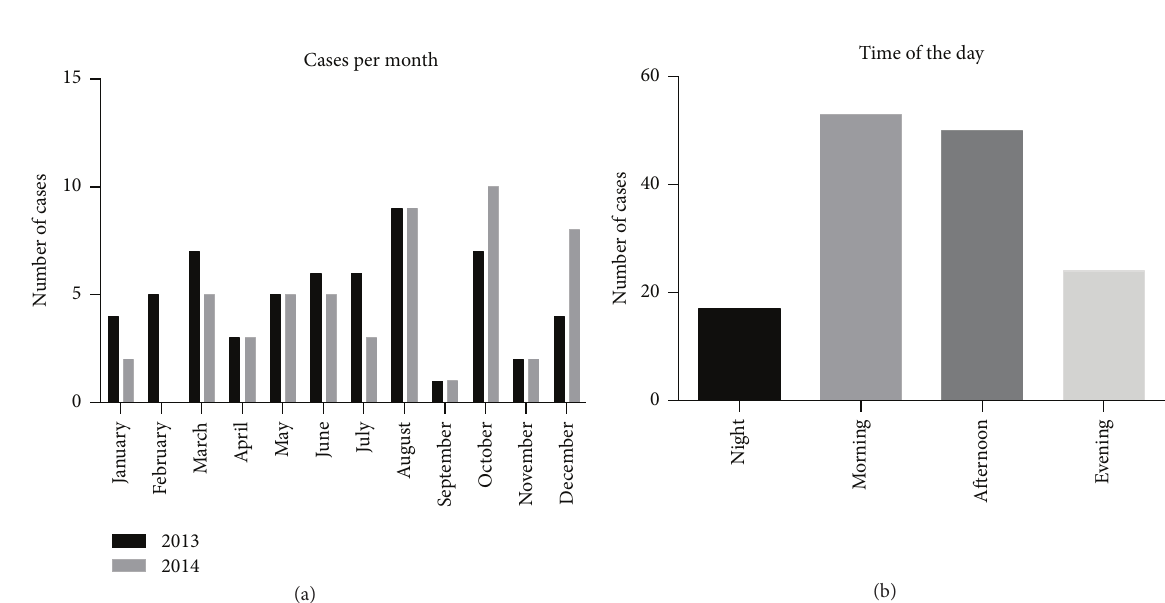
Figure 1: (a) Number of patients with suspected mandibular fracture. The monthly incidence was summed for years 2013 and 2014 ( 𝑛 = 112 ). (b) Number of mandibular fractures by time of day. Morning, 06:00–11:59; afternoon, 12:00–17:59; evening, 18:00–23:59; night,